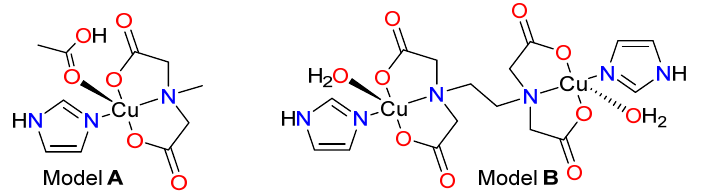
Figure 9. Representation of the theoretical models of 1 used to investigate the noncovalent interac- tions.